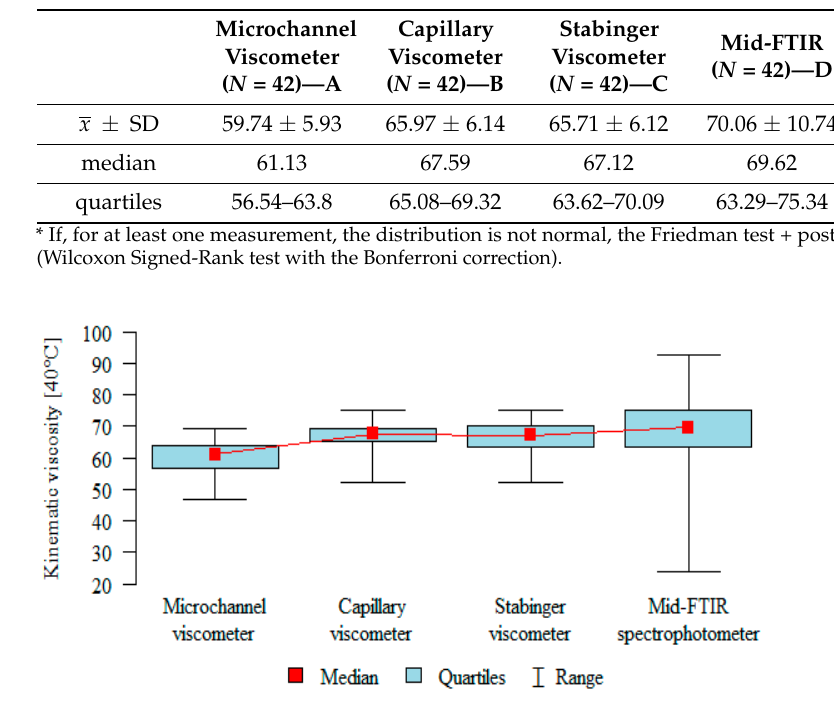
Table 6. The mean values ( 𝑥) , standard deviations (SD), and p *-values.